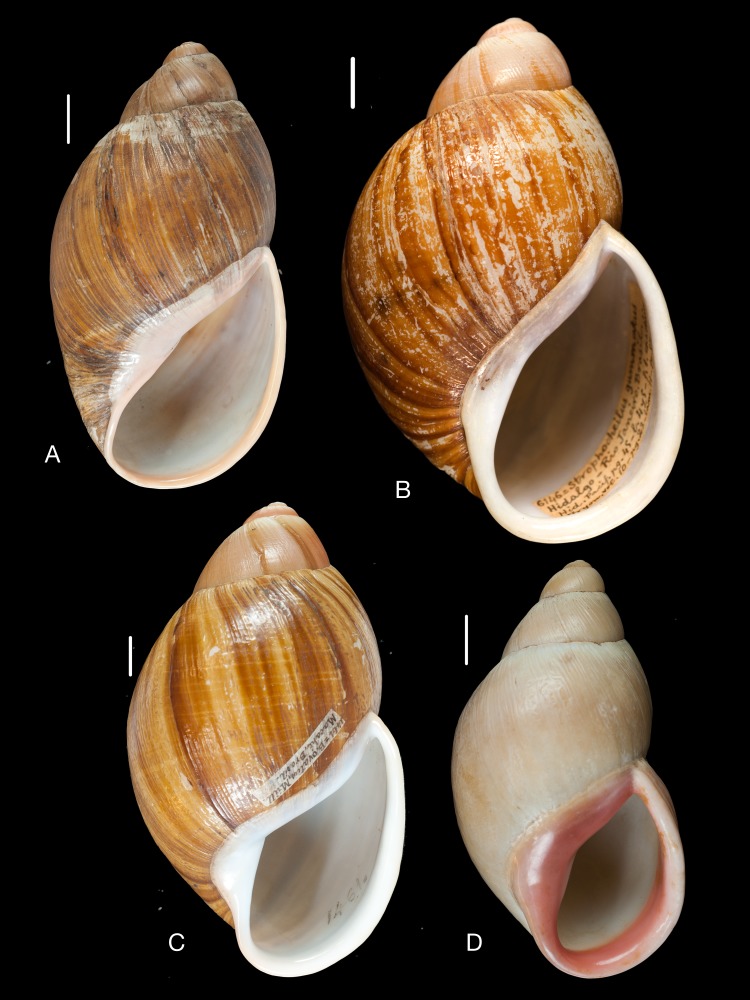
Material collected by the CCP.(A–D) Strophocheilidae. Megalobulimus granulosus (Rang, 1831), MNCN 15.05/13294, (A) ventral view; Megalobulimus gummatus (Hidalgo, 1870), MNCN 15.05/3199, (B) ventral view; Megalobulimus ovatus (Müller, 1774), MNCN 15.05/7336, (C) ventral view; Megalobulimus oblongus (Müller, 1774), MNCN 15.05/36948, (D) ventral view. Scale line 1 cm.